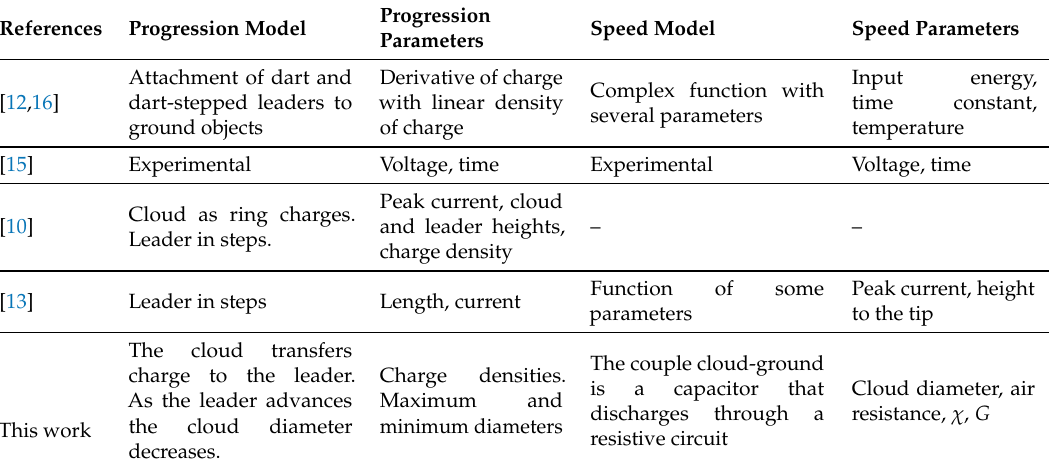
Table 1. Comparison to previous